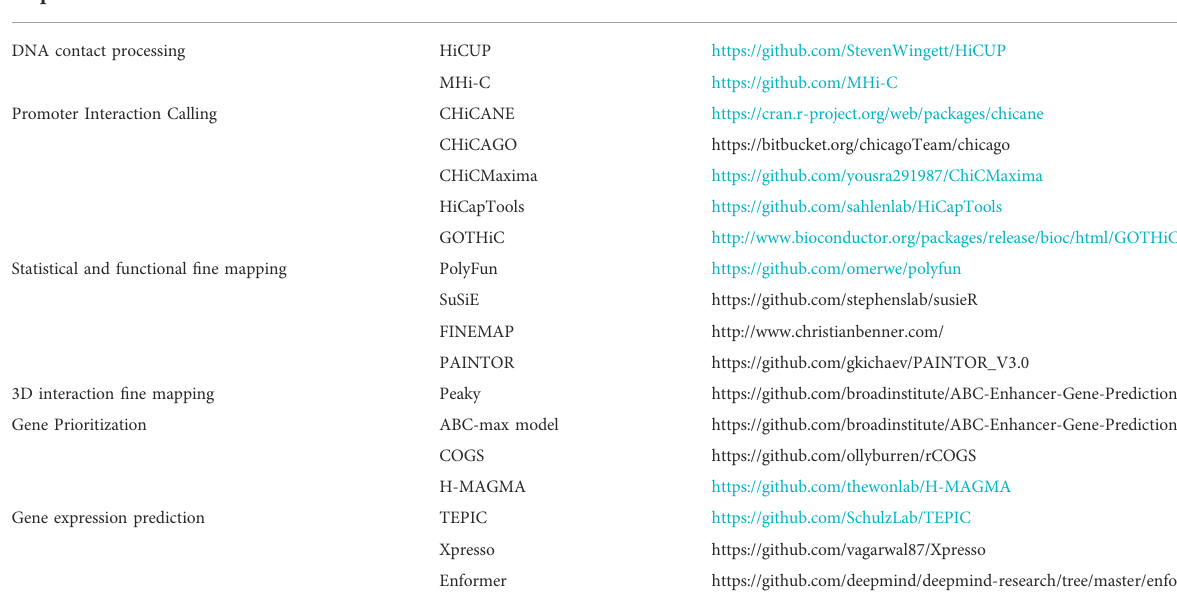
TABLE 1 Selected software for integrating 3D functional genomes with disease